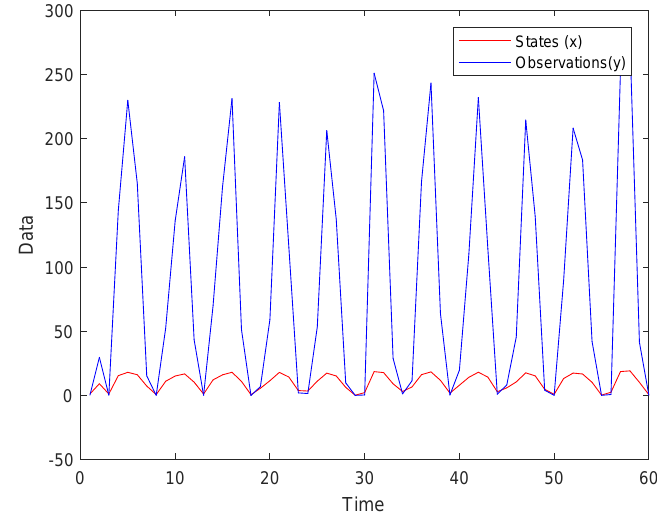
Figure 1. Estimated states of different filters and true states in model 1.